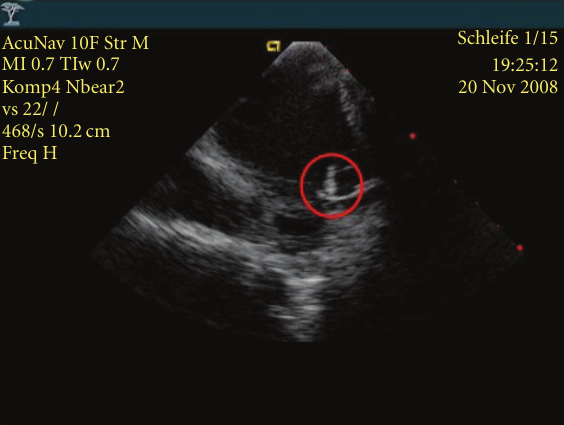
Figure 2: A mobile thrombus (encircled) is attached to the tip of the transseptal sheath before the advancement of a catheter and before heparin